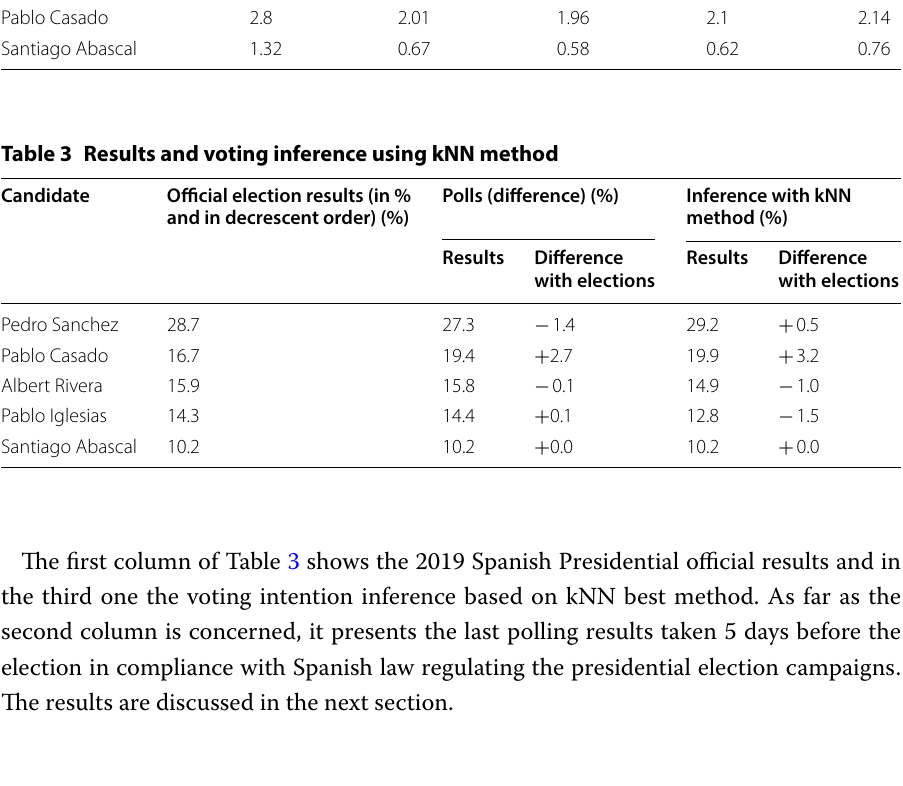
Table 2 Performance of the five models by candidate MAE LDA CART kNN SVM RF Pedro Sanchez 1.79 1.04